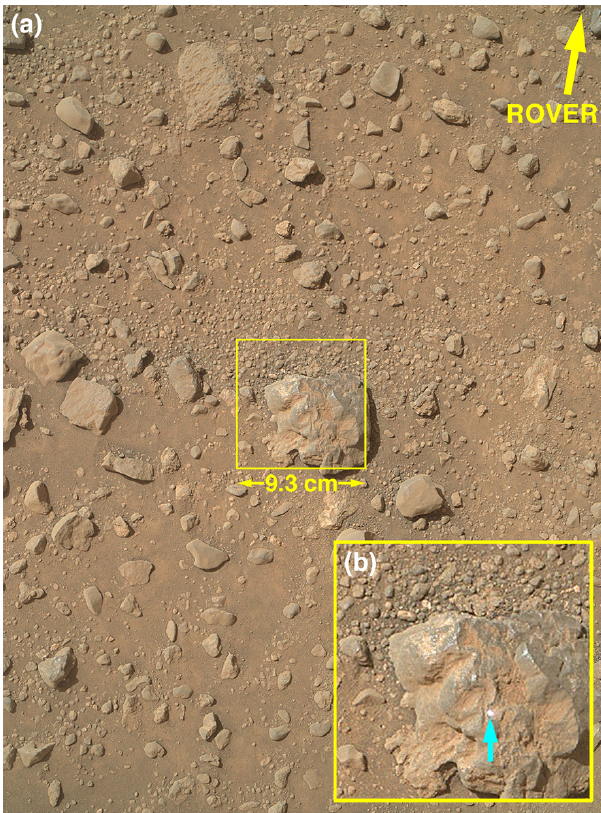
Figure 13. MAHLI images of the stone target named Nova, illumi- nated by sunlight from the left, acquired from 1m distance on sol 687 (13 July 2014) to record, for the first time on Mars, a ChemCam LIBS investigation in action. (a) Full MAHLI field of view, cover- ing Nova and its context, with direction to the front of the Curiosity rover indicated. The yellow box (scale, 9.3cm by 9.3cm) indicates the location of sub-frames acquired using MAHLI’s video capa- bility so as to image bright flashes from ChemCam laser-induced plasma. This is MAHLI image 0687MH0004150010203989C00. (b) MAHLI video sub-frame 0687MH0004160000203993M80, ex- panded 2 × in size; the blue arrow indicates a flash caused by LIBS- generated